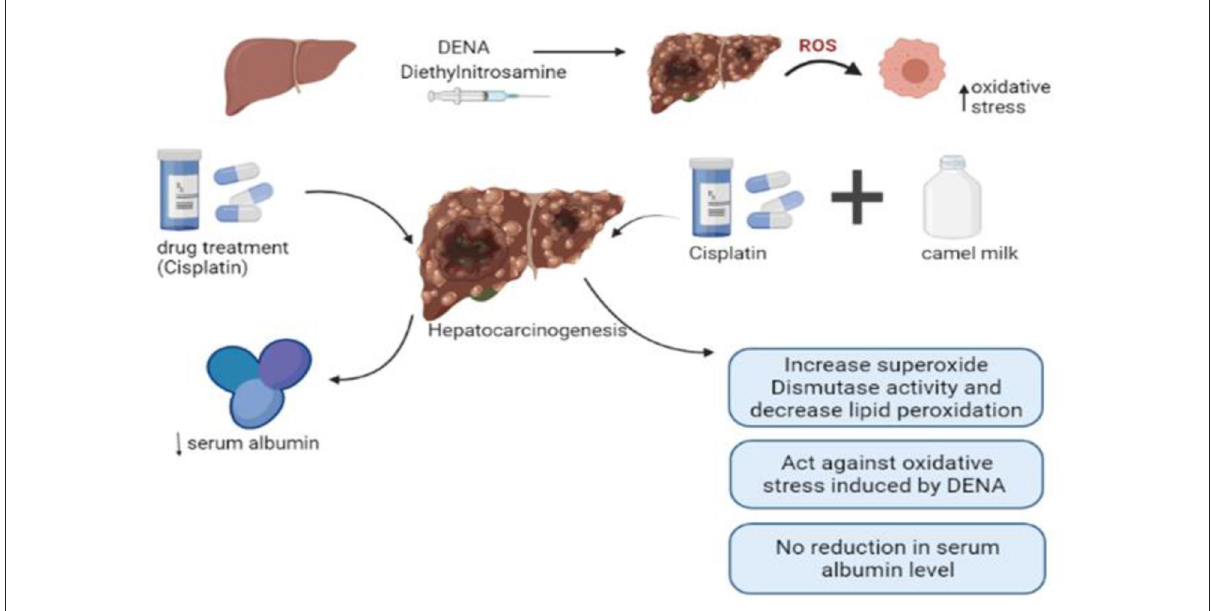
FIGURE1 Effect of camel milk in combination with drug